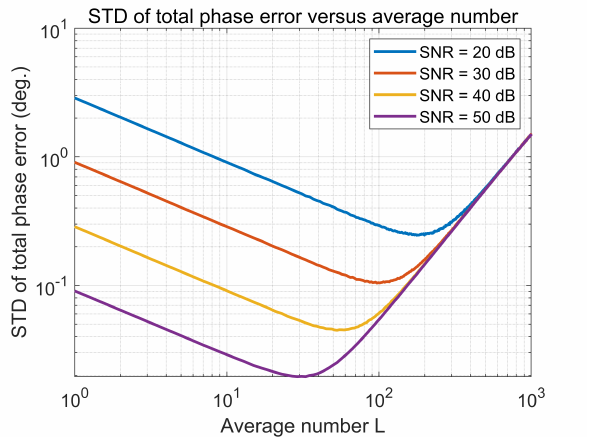
Figure 12. The STD of total phase error σ link versus average number L under different SNR